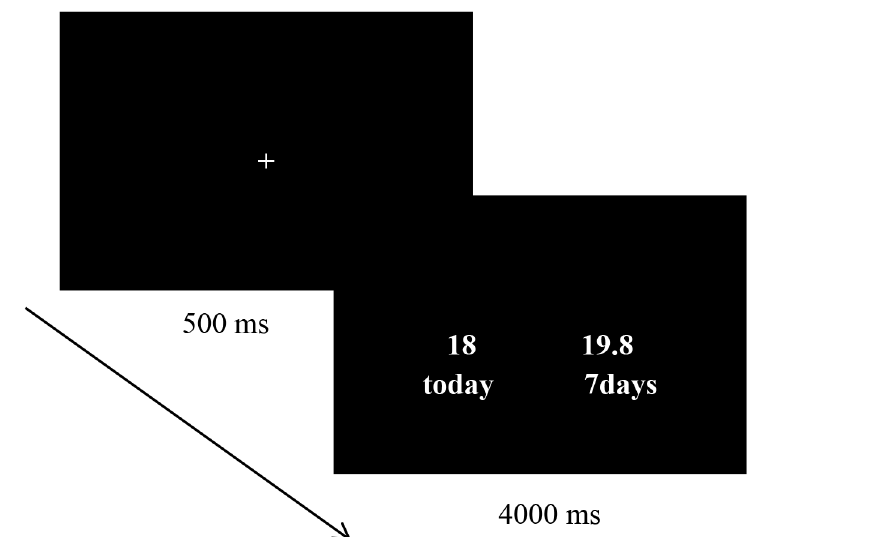
Fig 2. Process diagram of the intertemporal choice